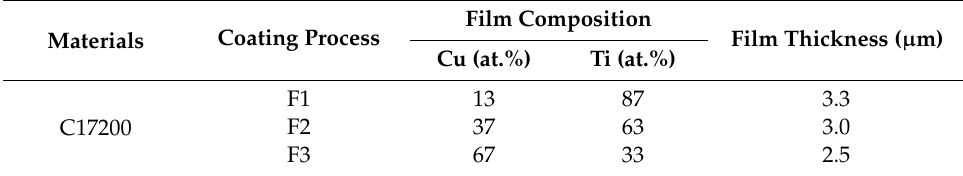
Table 4. The composition and thickness of the fabricated Cu-Ti film by magnetron sputtering on C17200 Cu